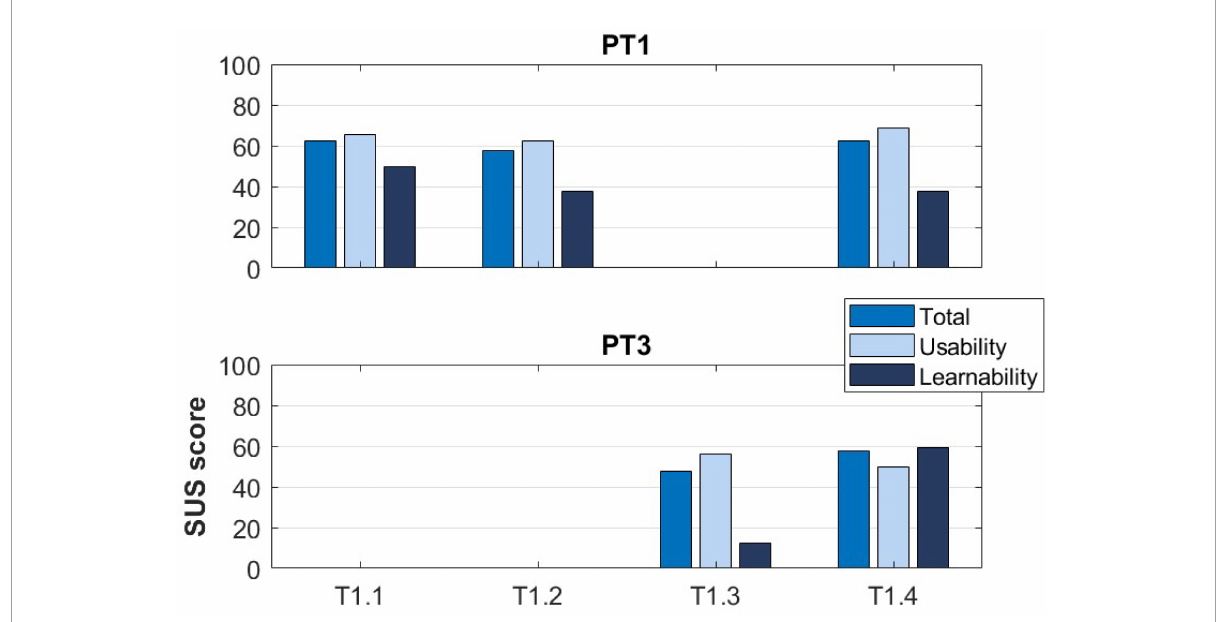
FIGURE2 The System Usability Scale (SUS) score and subscores reported by PT1 and PT3 at